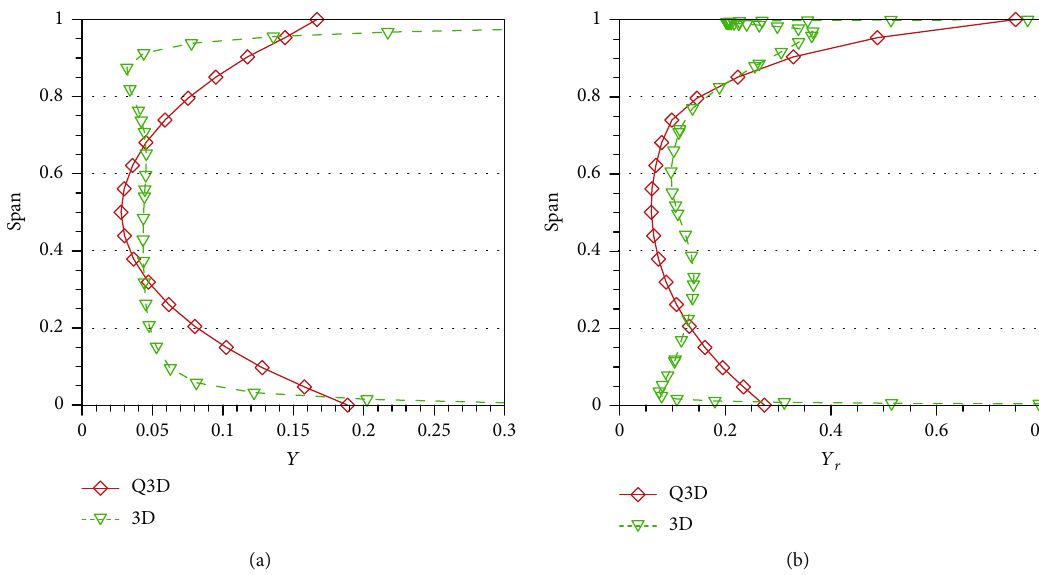
Figure 22: Total pressure loss of the single-stage turbine: (a) stator total pressure loss; (b) rotor relative total pressure loss.